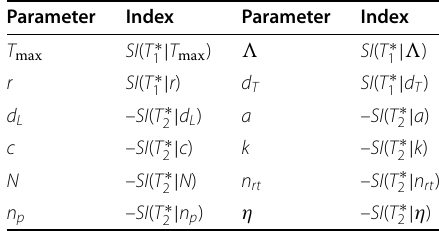
Table 5 Sensitivity indices for the basic reproductive number R 0